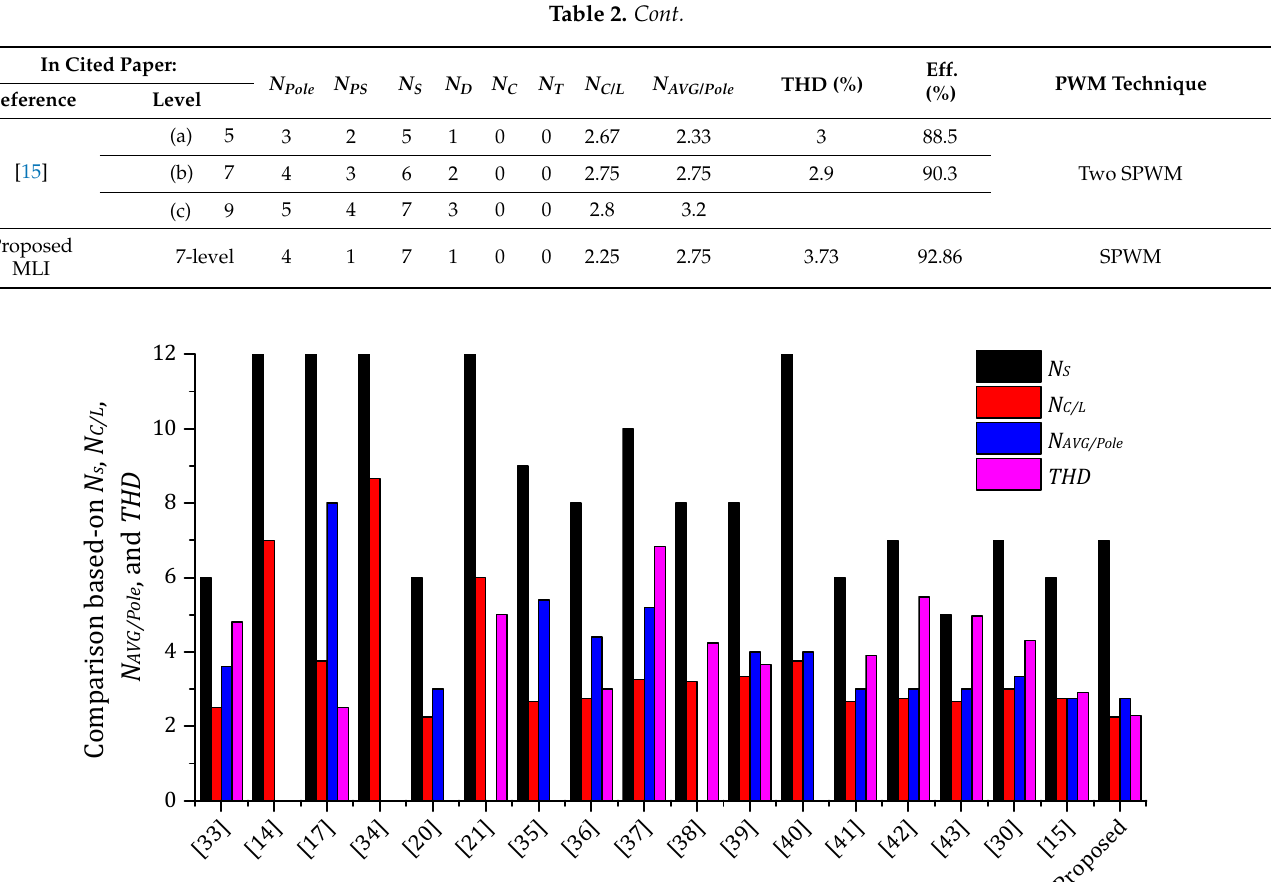
Figure 5. Comparison between the proposed 7-level inverter and the recent topologies.